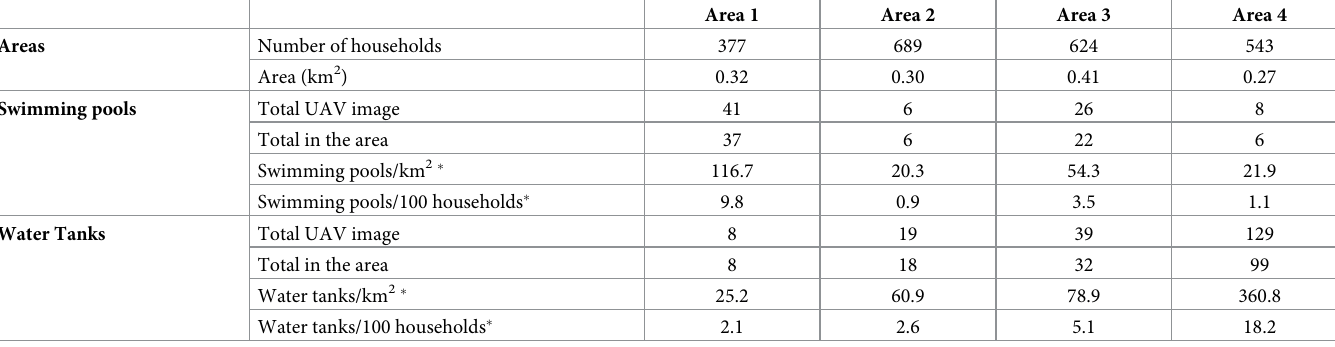
Table 3. Numbers and densities of swimming pools and water tanks per square kilometer and 100 households in the study areas of Campinas.